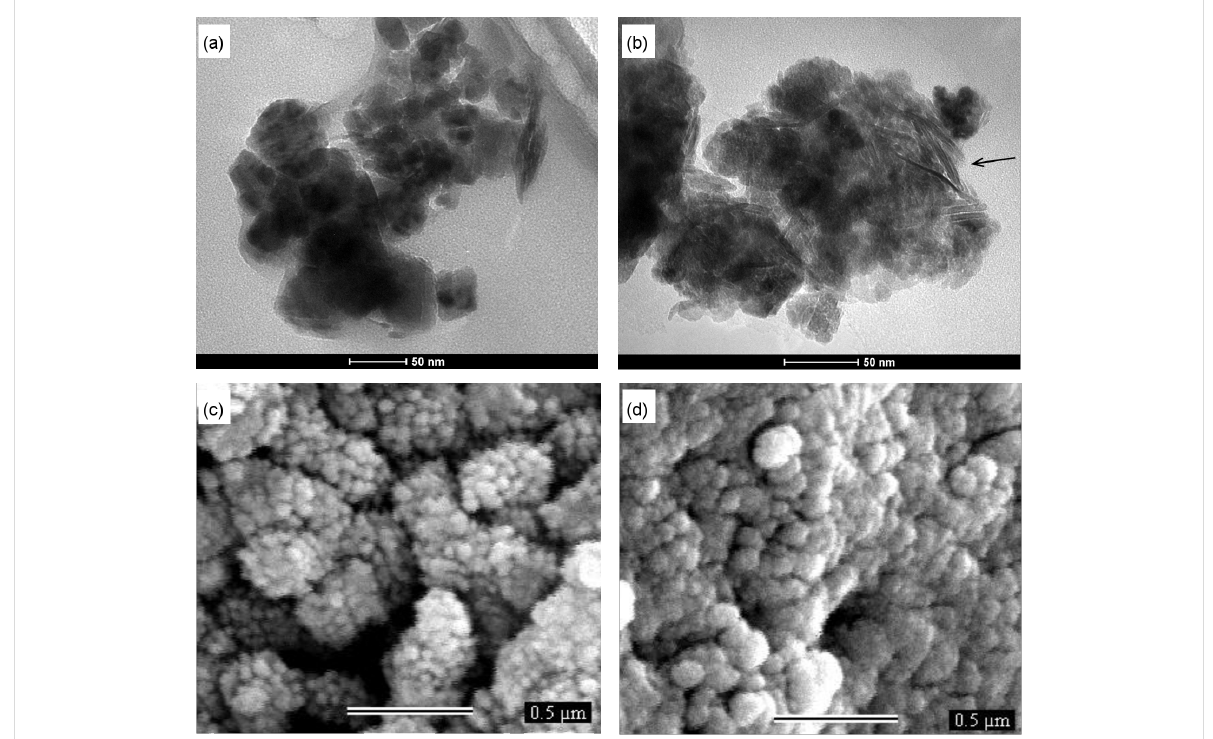
Figure 2: TEM images of (a) Fe-Ni/Zn and (b) Fe-Ni/Zn/ β CD and SEM images of (c) Fe-Ni/Zn and (d) Fe-Ni/Zn/ β CD.